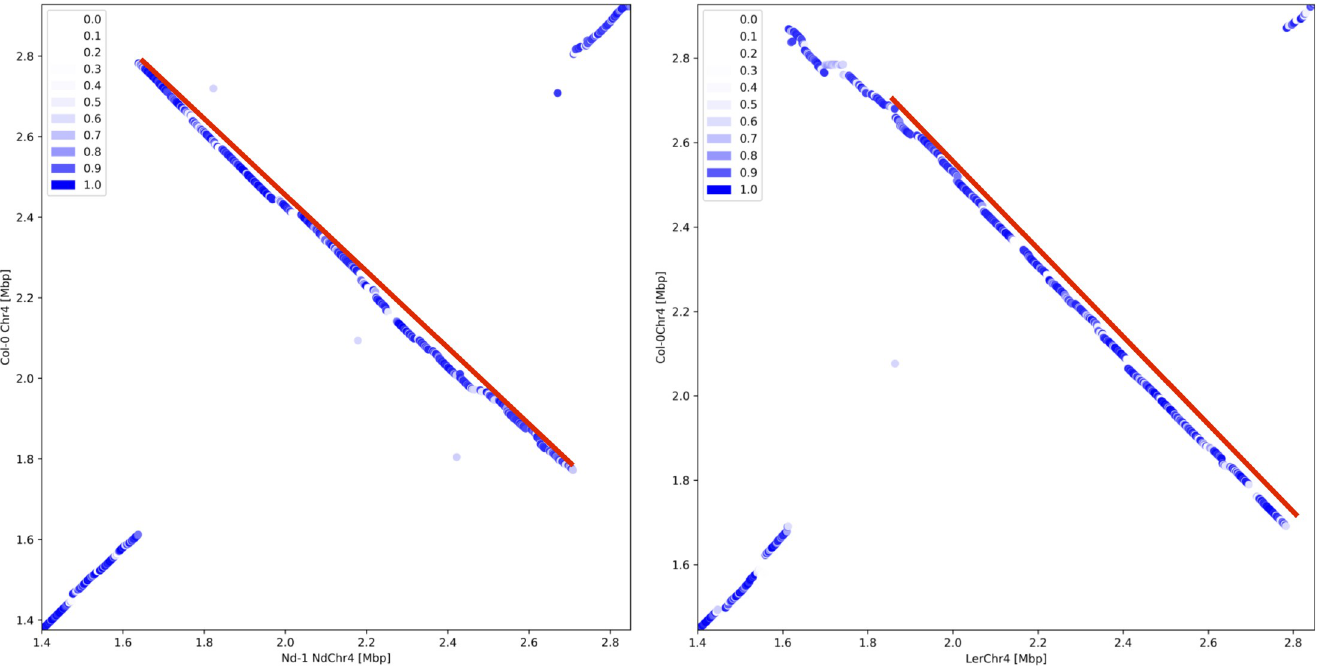
Fig 2. Inversion on chromosome 4. The dotplot heatmaps show the similarity between small fragments of two sequences. Each dot indicates a match of 1 kbp between both sequences, while the color is indicating the similarity of the matching sequences. A red line highlights an inversion between Nd-1 and Col-0 or L er and Col-0, respectively. A red arrow points at the position where the inversion alleles differ between Nd-1 and L er . (a) Comparison of the Nd-1 genome sequence against the Col-0 gold standard sequence reveals a 1 Mbp inversion. (b) The L er genome sequence displays another inversion allele [14].